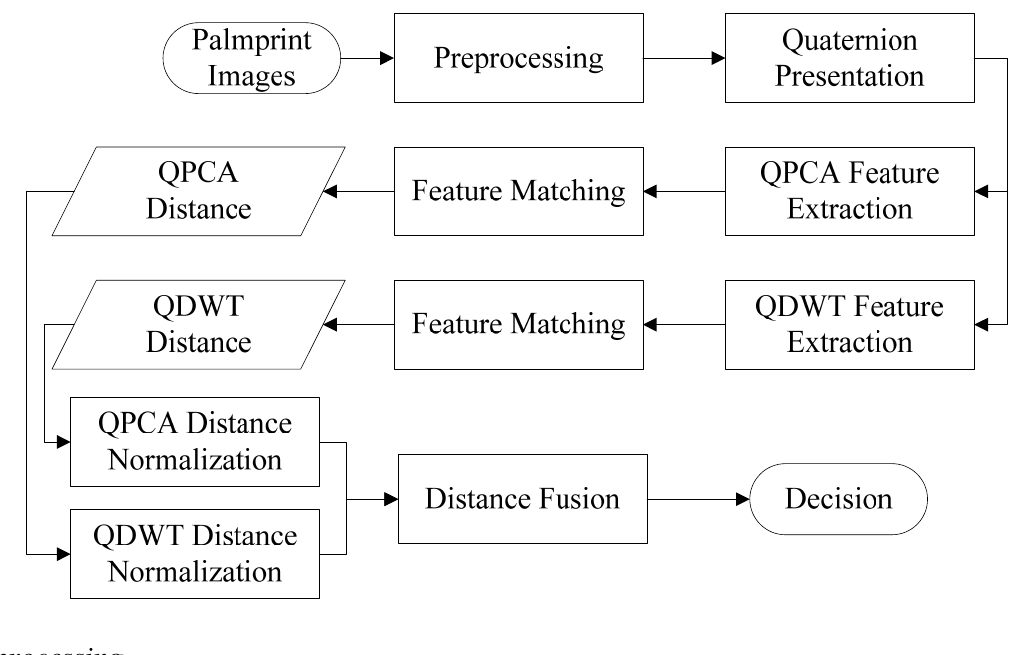
Figure 3. The framework of the proposed